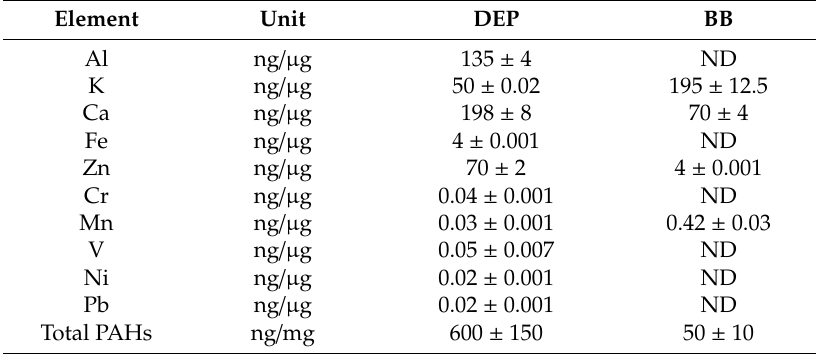
Table 1. Chemical compositions of ultrafine particles (UFPs) from di ff erent anthropogenic sources, as reported in Longhin et al., 2016. [10]. Each value is expressed as mean concentration ( ± SD). DEP—diesel exhaust particles; BB—biomass burning-derived particles; PAH—polycyclic aromatic hydrocarbon; ND—not